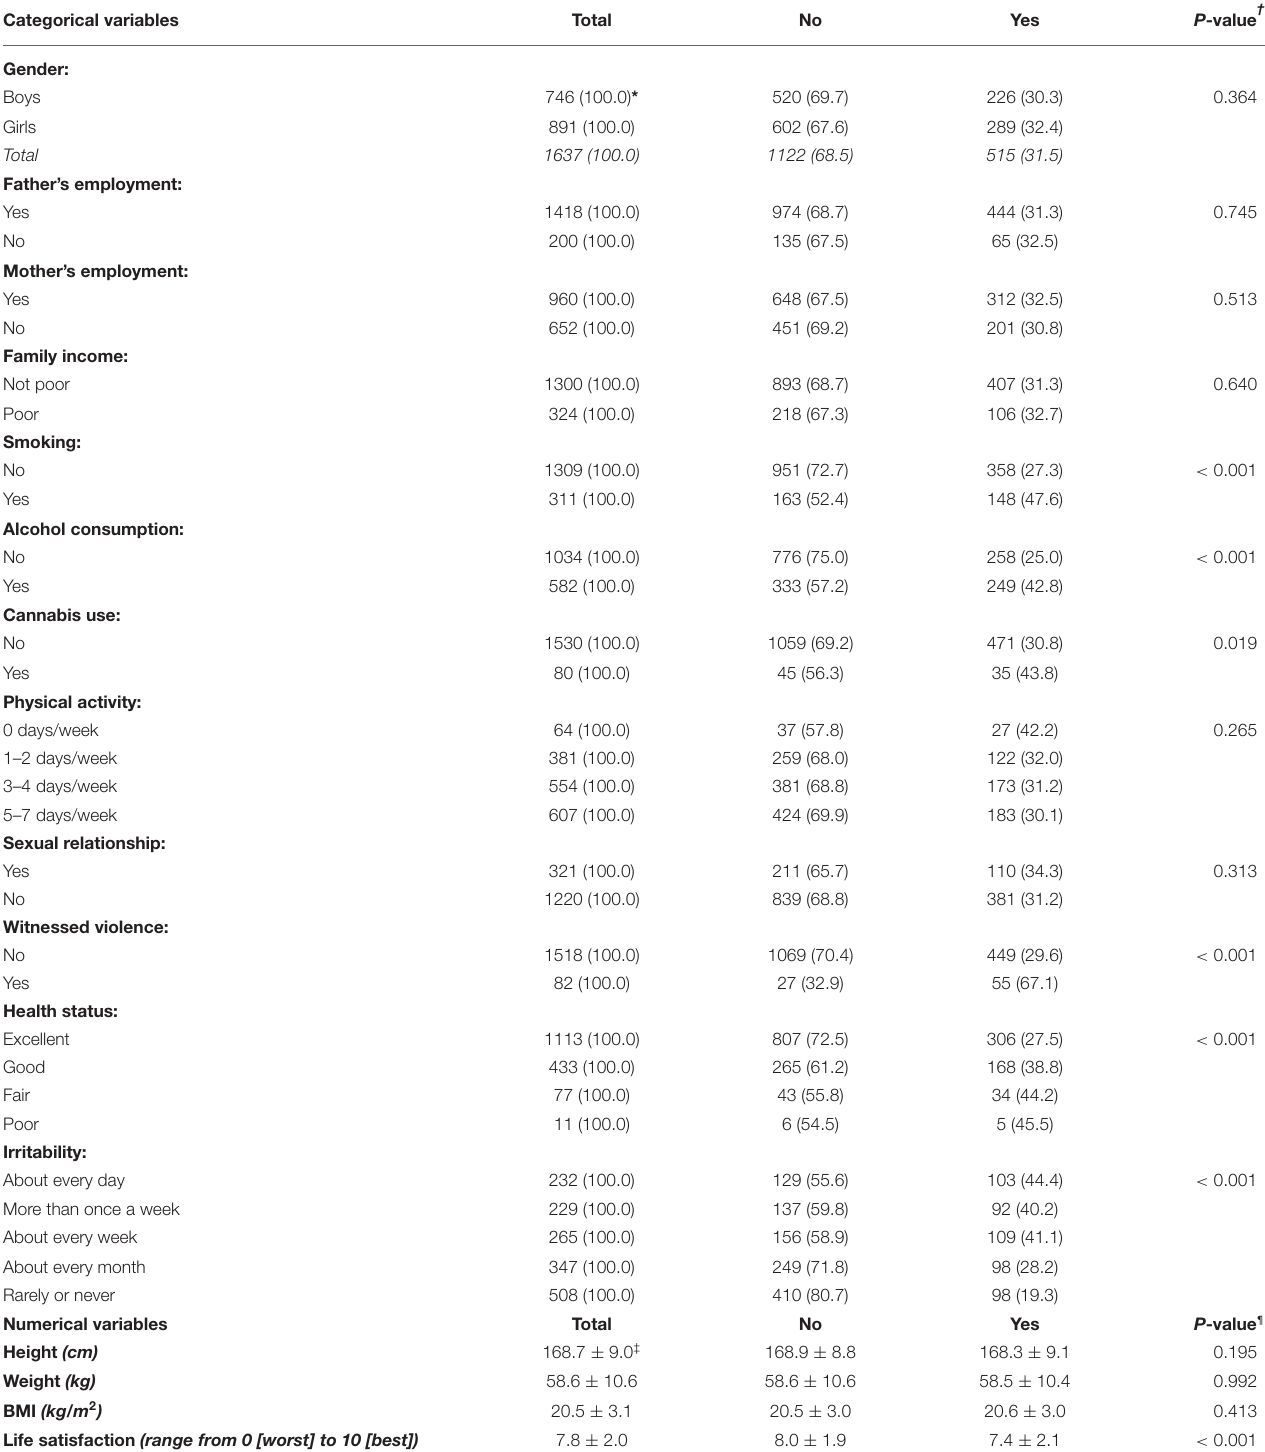
TABLE 1 | Distribution of lifetime physical abuse by socio-demographic characteristics, lifestyle factors and health status of Albanian schoolchildren aged 15 years, HBSC 2017–18. Categorical variables Total No